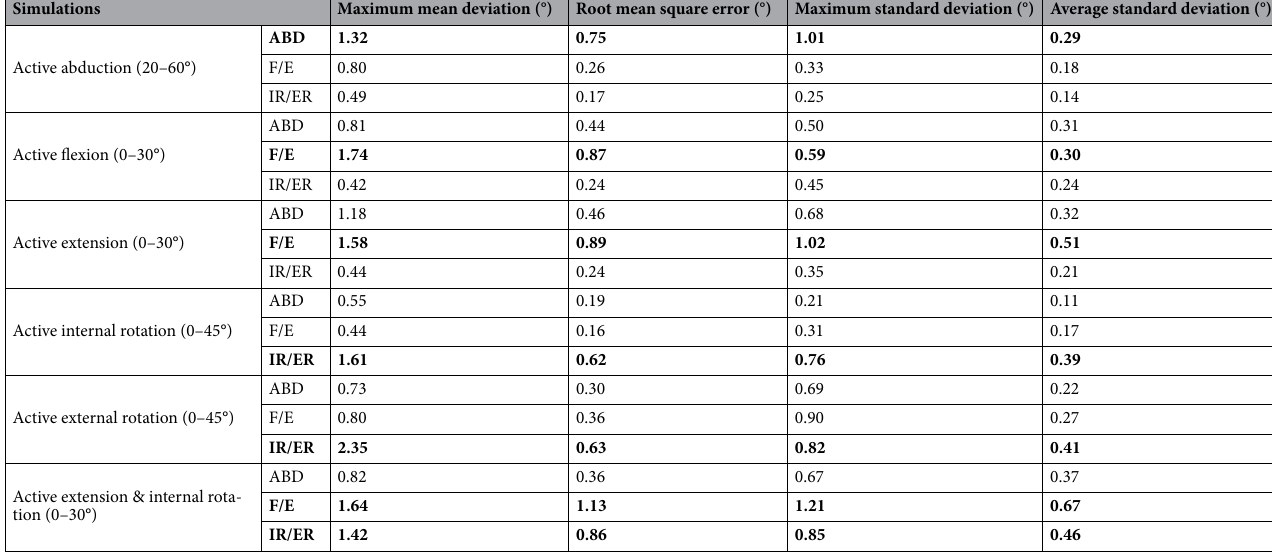
Table 3. Parameters of all PID controllers in the simulator. ABD Abduction, AP Anterior–posterior, F/E Flexion/extension, IR/ER. Significant values are in